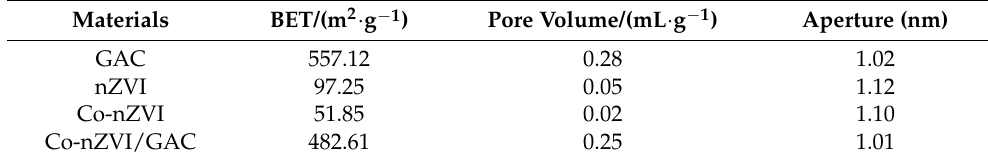
Table 1. Specific surface areas of different materials.